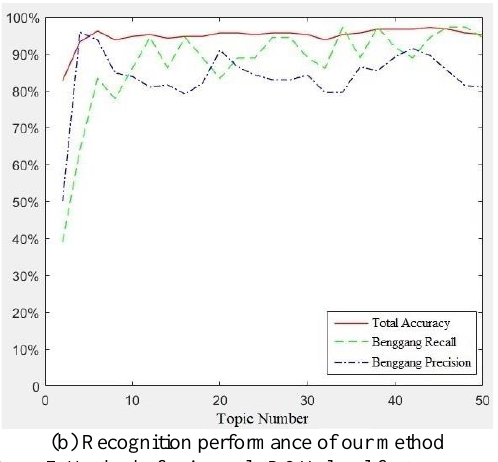
Figure 7. Method of using only DOM local features vs. our method